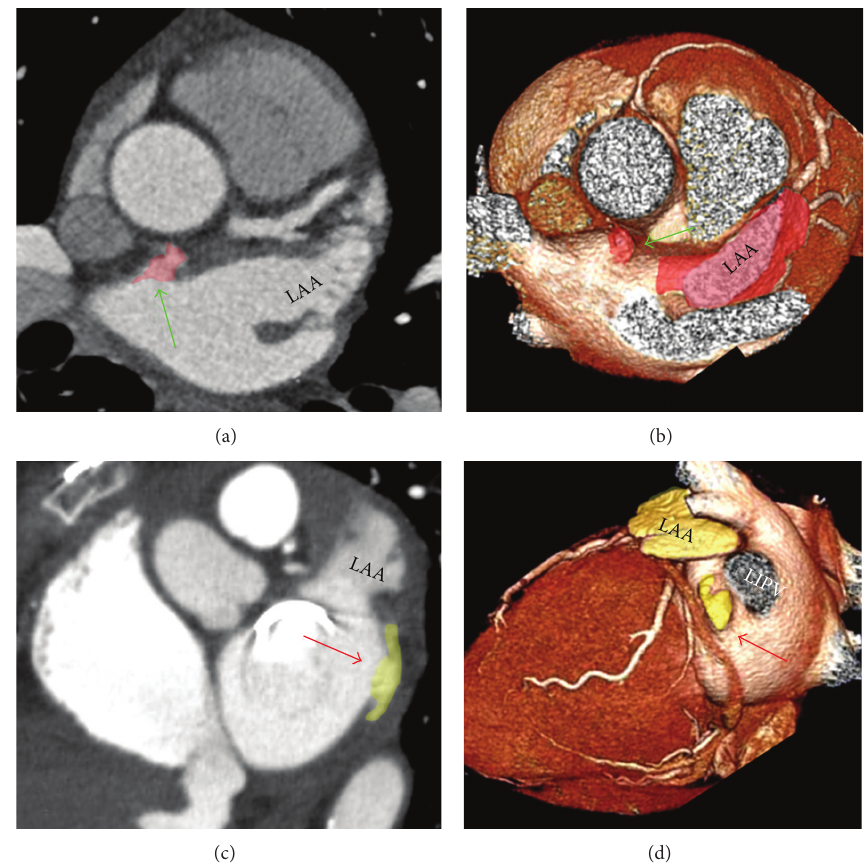
Figure 10: Small accessory appendages are common findings in the left atrial wall presenting as small outpouchings with irregular margin in the left atrial wall arising from the anterior wall (green arrow) and the mitral isthmus (red arrows). The left atrial isthmus is the area between the orifice of the left inferior pulmonary vein (LIPV) and the posteroinferior margin of mitral annulus.